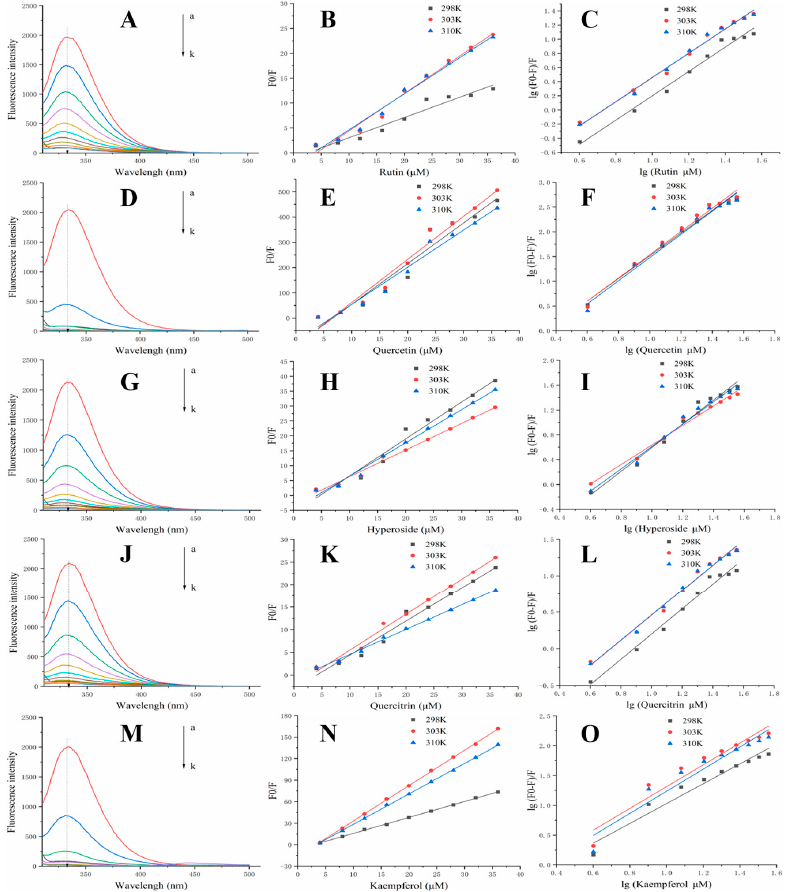
Figure 2. Fluorescence spectra and values of α -glucosidase in the addition of inhibitors under dif- ferent concentrations (( A – C ) represent RU; ( D – F ) represent QU; ( G – I ) represent HY; ( J – L ) represent QI; ( M – O ) represent KA)), a–k concentrations were 10 μ L of polyphenol solution (0.02 mg/mL) were added in 11 portions. RU represents rutin, QU represents quercetin, HY represents hyperoside, QI represents quercitrin, KA represents, kaempferol.